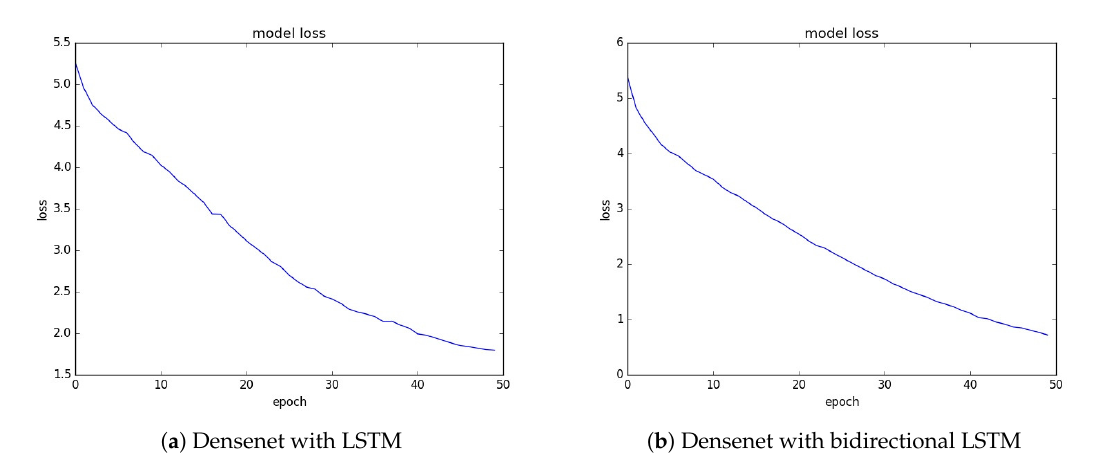
Figure 6. Comparison of the losses of different models.